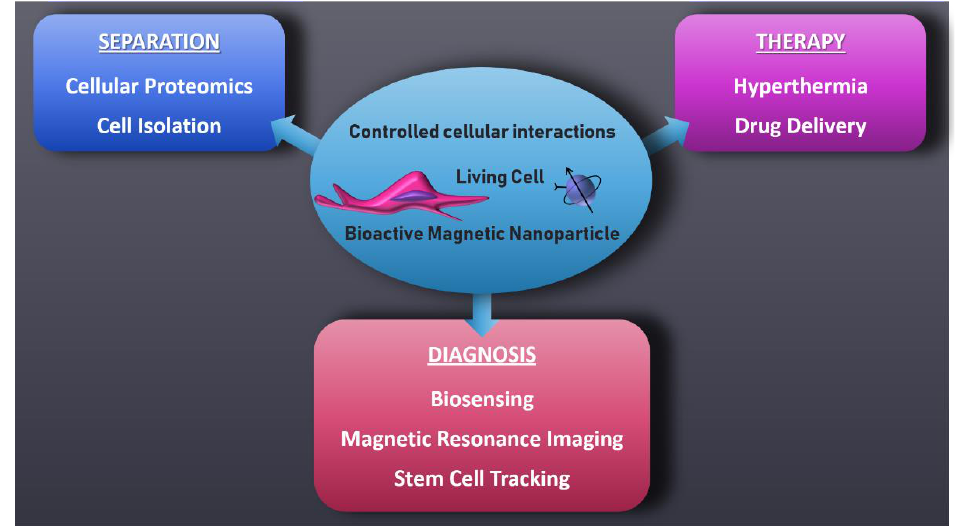
Figure 23. Biomedical applications of magnetic nanoparticles.